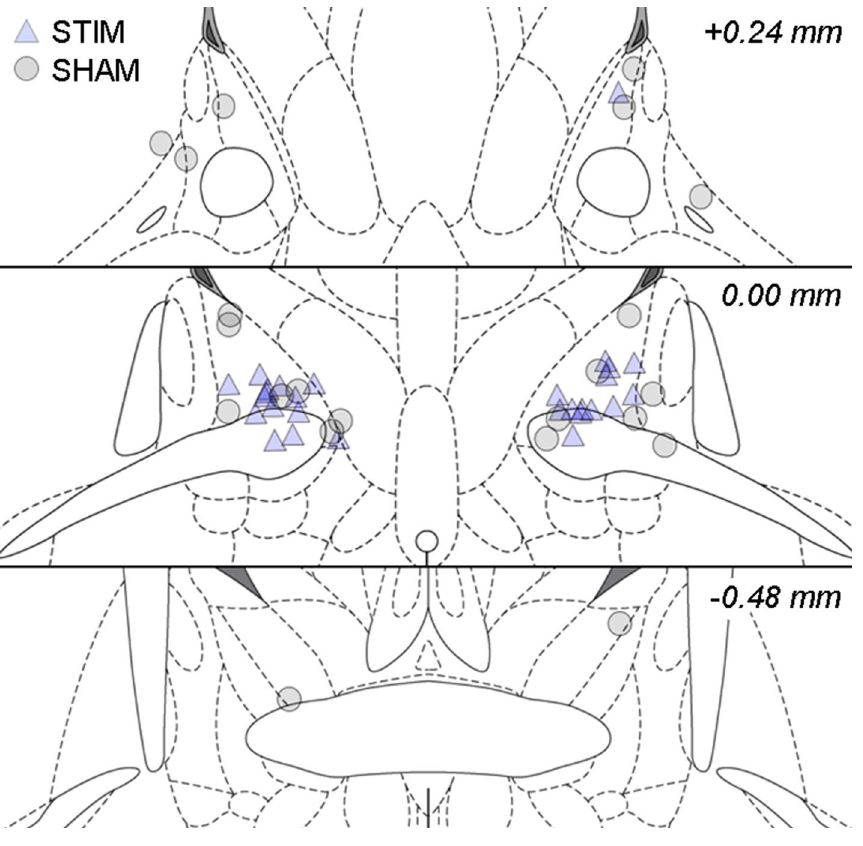
Figure 4. Reconstruction of electrode tip locations in Experiment 2. Triangles represent STIM animals (n = 14), circles represent SHAM animals (n = 11). Coronal slices shown from top to bottom are + 0.24 mm, 0.00 mm and − 0.48 mm, with respect to bregma. Figure adapted from Paxinos and Watson 50 .